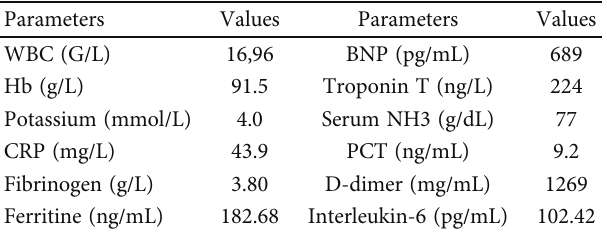
Figure 2: Chest X-ray images on admission (left) and postextubation (right) showed bilateral ground glass opacities consistent with mild COVID-19. Table 1: Patient ’ s laboratory results upon admission to the COVID-19 intensive care